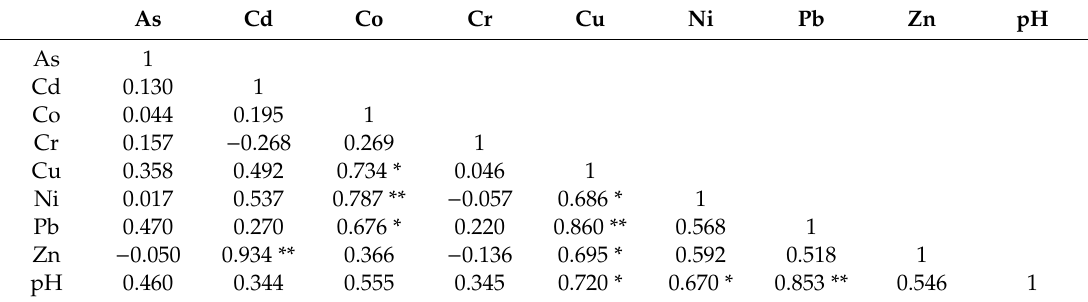
Table 5. Pearson’s correlation coe ffi cients calculated for the potentially toxic elements and